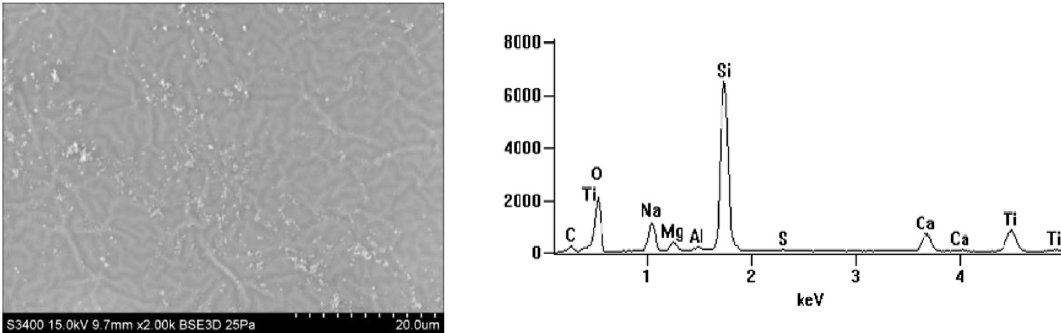
Fig. 5: Results of microstructure and EDS/SEM analysis of glass refined using titanium oxide (TT) nano-particles